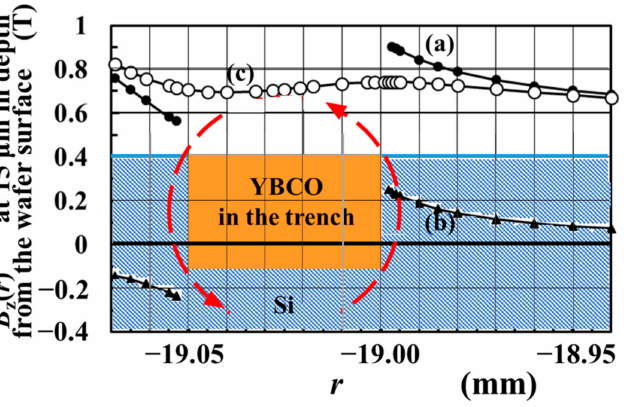
Figure 7. Calculated values of B z ( r ) in the vicinity of the innermost trench. ( a ) By Type I, ( b ) by Type I for a single circular trench, and ( c ) by Type